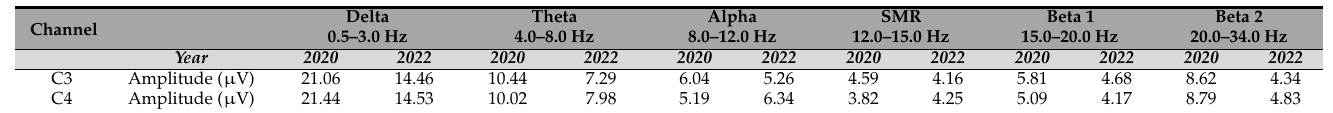
Table 2. Comparison of QEEG results from April 2020 (before neurofeedback treatment) and from July 2020 (directly after completing the neurofeedback treatment program). Channel